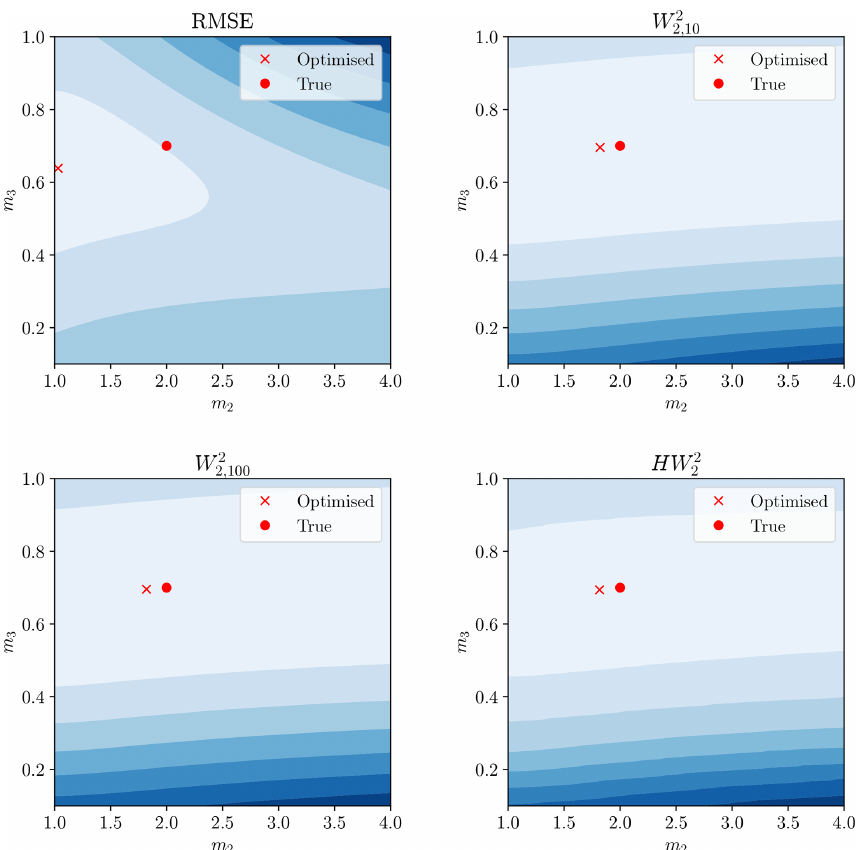
Figure 13. The same display as Fig. 11 but considering model parameters m 2 and m 3 . Red circle still denotes true parameters and red cross the minimum of this surface.